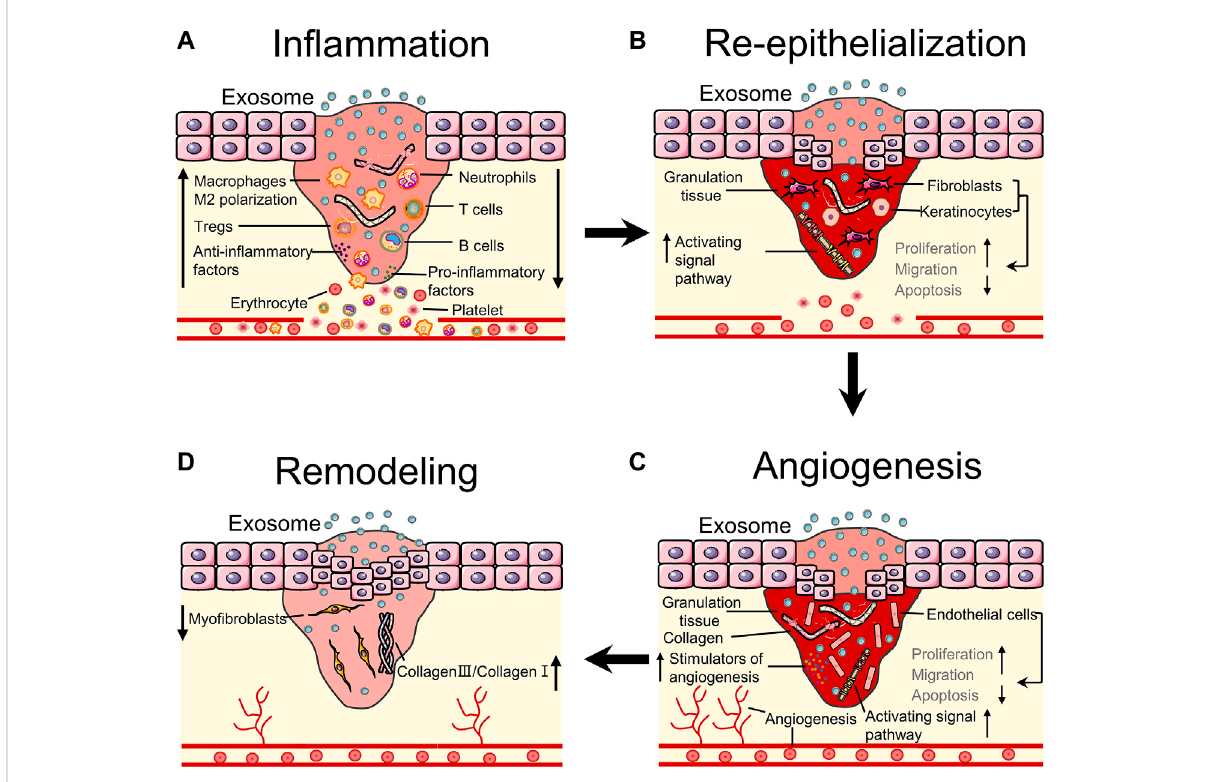
FIGURE 3 Bioeffects ofstem cellsderived exosomes on wound healing. (A) EdSC can inhibitin fl ammationby regulating thenumber ofin fl ammatorycells and the polarization of macrophages. (B) EdSC can promote re-epithelialization by increasing the activity of fi broblasts as well as keratinocytes and activating pathways. (C) EdSC can improve angiogenesis by stimulating the release of angiogenic factors and regulating the activity of endothelial cells. (D) EdSC can improve tissue remodeling by regulating the ratio of collagen and myo fi broblast